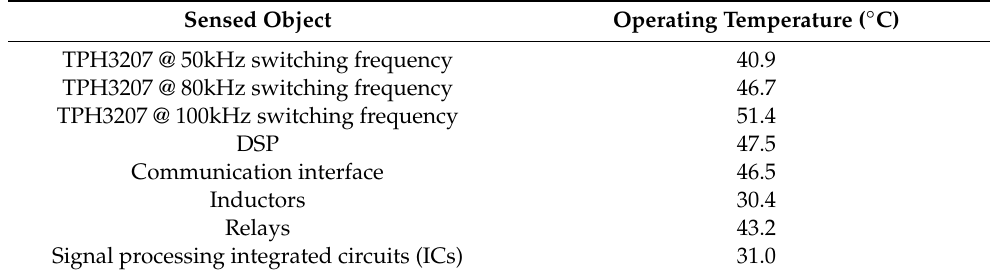
Table 6. Summary of operating temperatures of individual